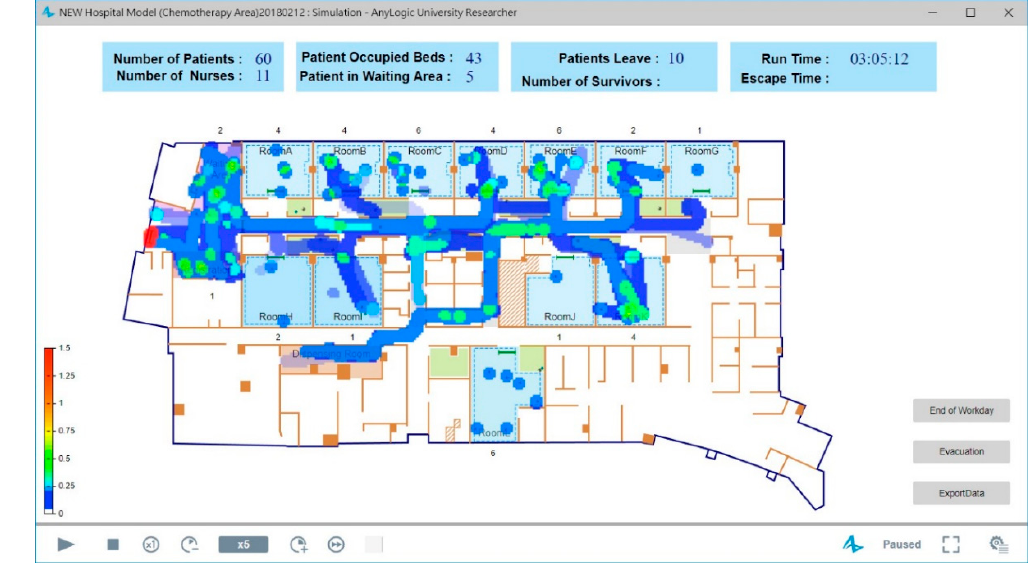
Figure 7. The simulation results for the regular process with pedestrian density.